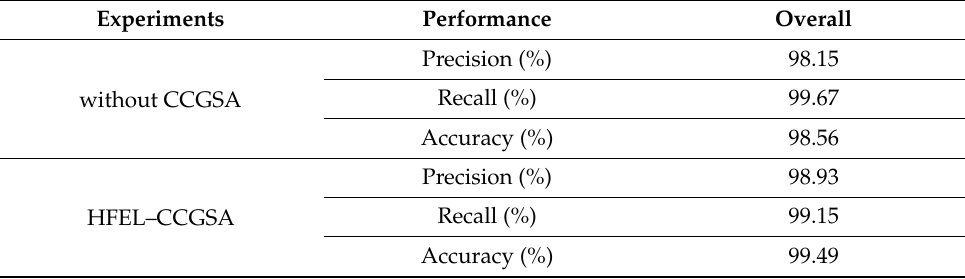
Table 7. Performance analysis for ‘without CCGSA’ and HFEL–CCGSA method on Eurosat